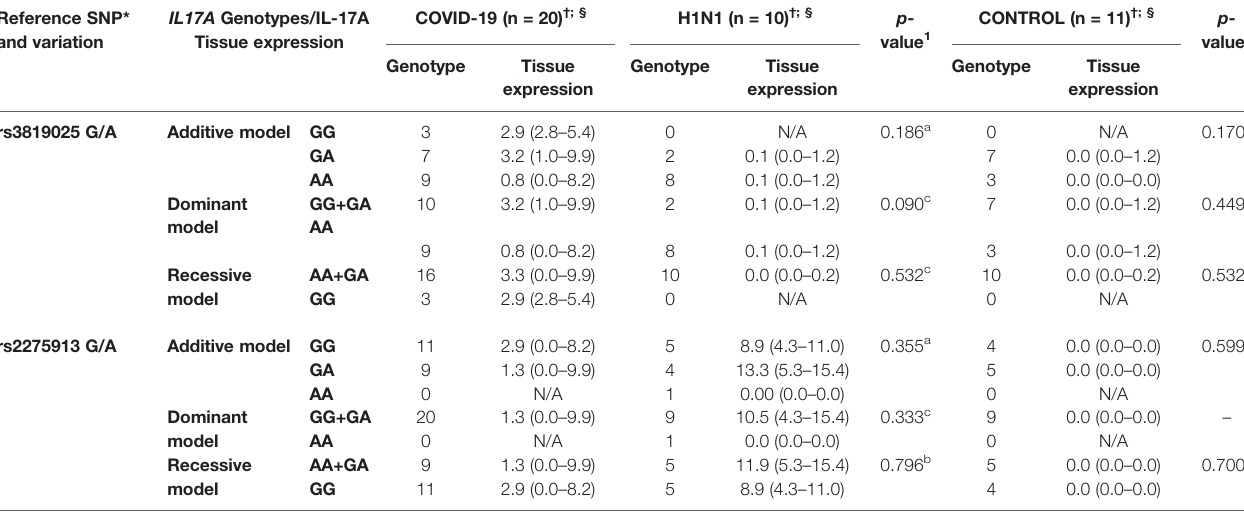
TABLE 2 | IL-17A tissue expression and IL17A polymorphisms in all three groups. Reference SNP* and